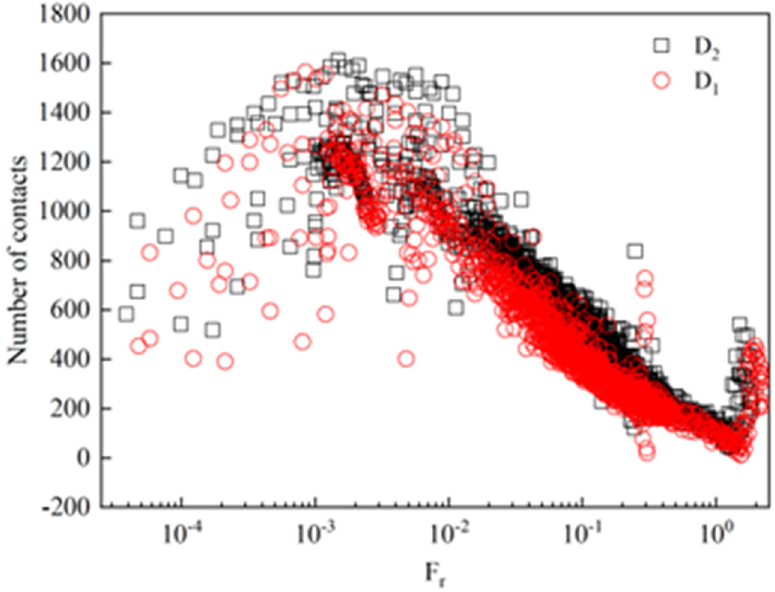
Figure 10. Vectors of the particle velocities at transient changing rotational speeds.